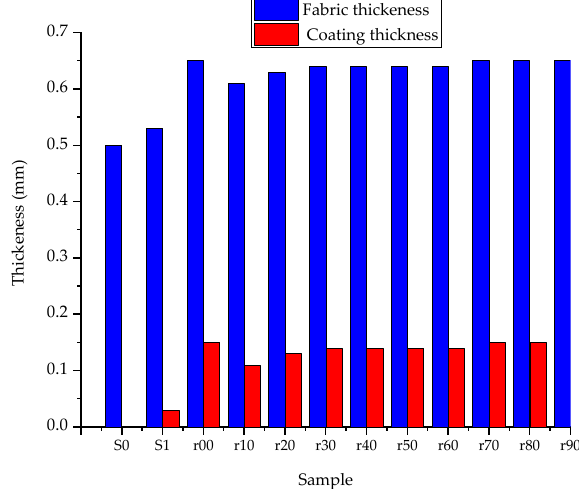
Figure 7. E ff ect of PEDOT:PSS / PDMS-bb-PEO on Figure 7. Effect of PEDOT:PSS/PDMS-bb-PEO on thickness.